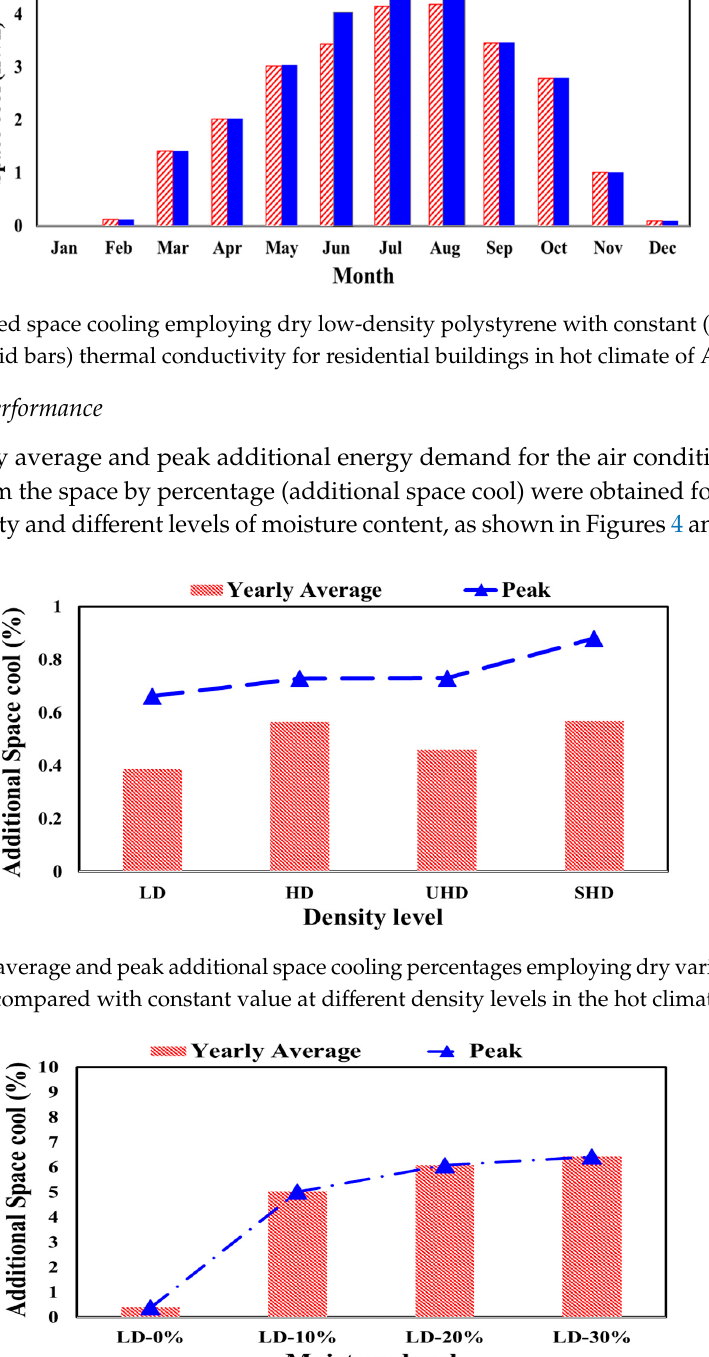
Figure 2. Average hourly and total solar radiation of Al-Ain, UAE for a typical day of each month.